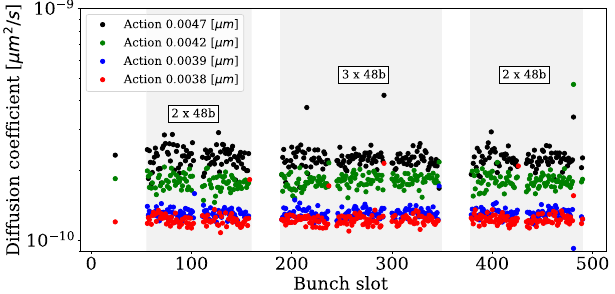
FIG. 16. In red, the diffusion coefficient for the different bunches computed from beam loss data (collected by dBLM ¼ 0 . 0021 μ m and acquisition mode 2), during one scan step (at J i corresponding to the jaw position at 3 . 6 σ ) in fill 7392 for beam 1, is shown (details in Table III). In blue, the number of beam-beam long-range encounters per bunch slot is